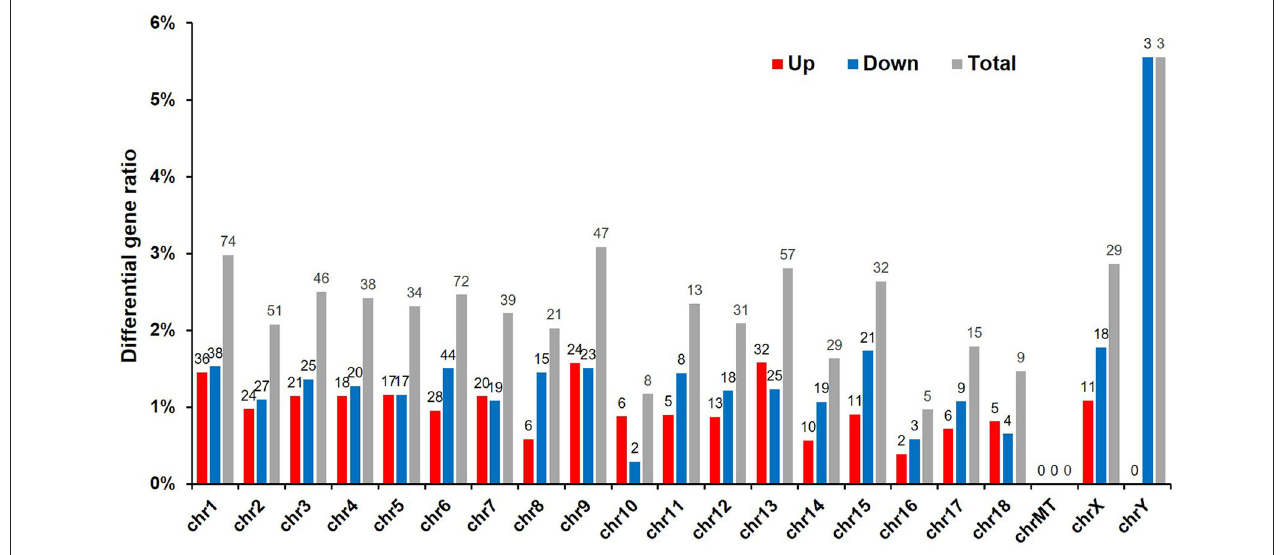
FIGURE 3 | Chromosomal locations of differentially expressed genes (DEGs). Sequencing results led to the identification of 540 DEGs ( p < 0.05). Red, number of upregulated genes; blue, number of downregulated genes; and gray, total number of genes that were differentially expressed in response to the vitrification/thawing